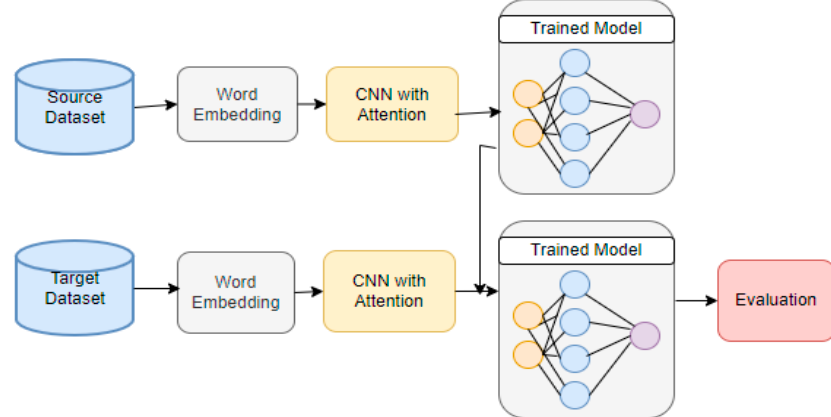
Figure 3. Learning process using transfer learning.